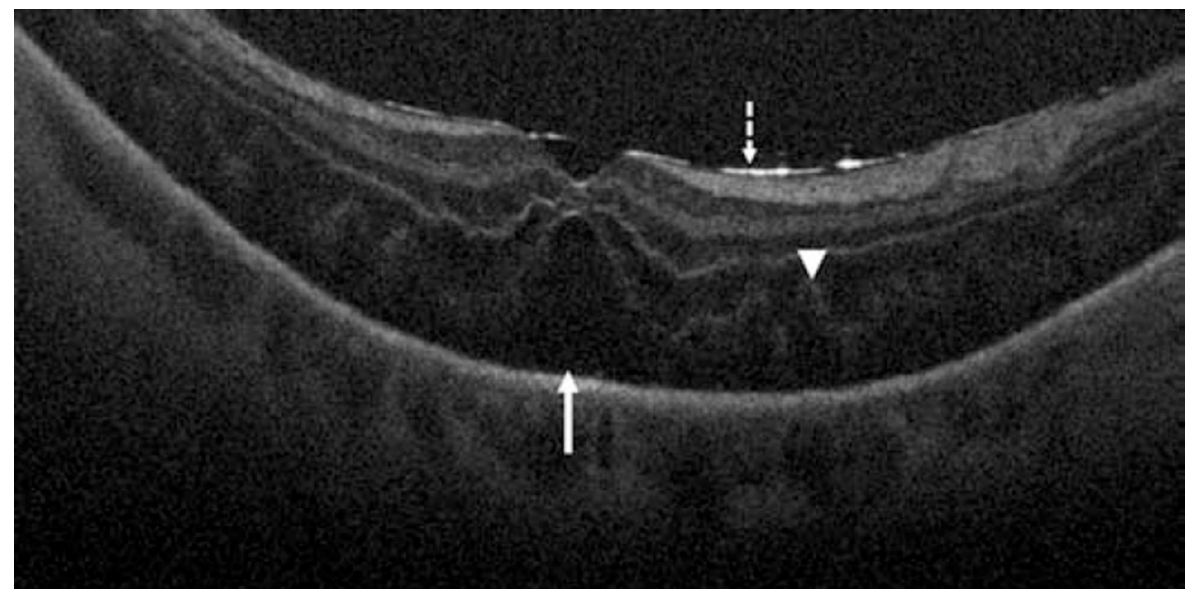
Figure 9. Retinal detachment visualized by intraoperative OCT. Dashed arrow shows hyperreflective retina and perfluorocarbon liquid interface, arrowhead shows outer retinal corrugations, and solid arrow shows persistent subretinal fluid. Reprinted with permission from Ehlers et al. [115]. The Prospective Intraoperative and Perioperative Ophthalmic ImagiNg with Optical CoherEncE TomogRaphy (PIONEER) Study: 2-year results. Am J Ophthalmol. 2014 Nov;158(5):999-1007 with license permissions obtained from Elsevier and Copyright Clearance